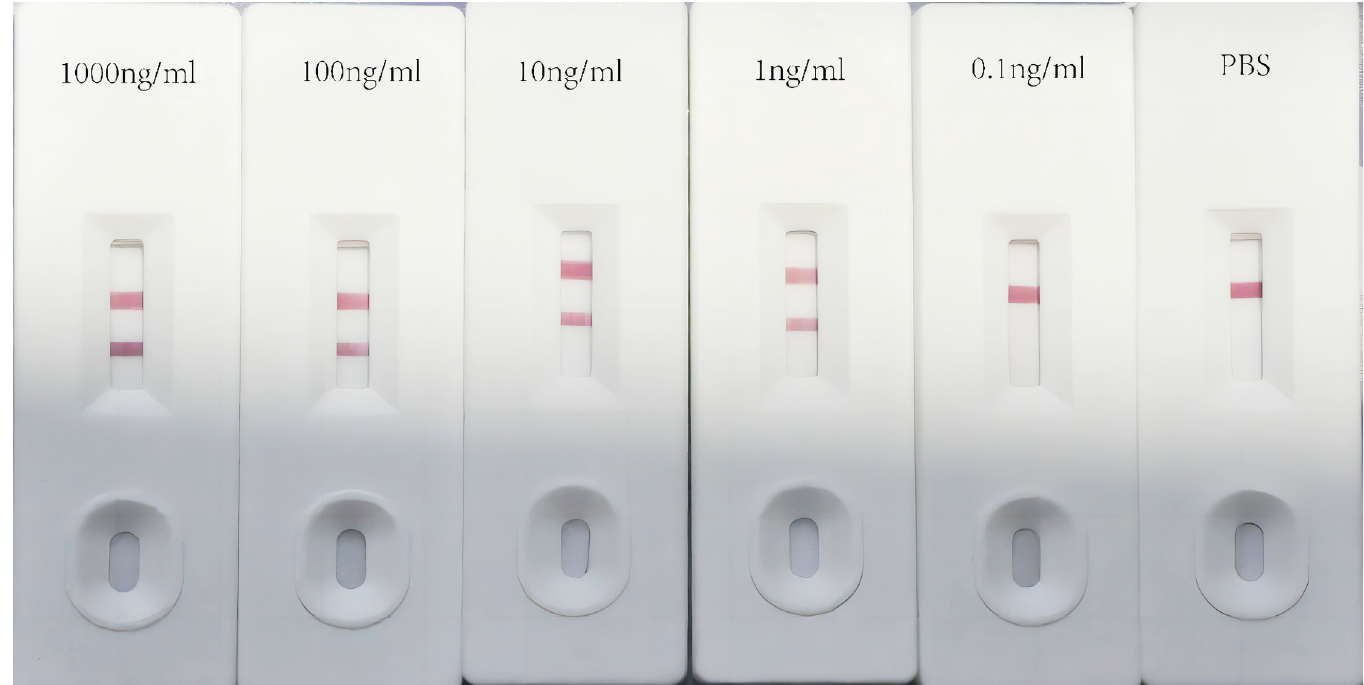
Fig 10. BM venom serially diluted to 1000 to 0.1 ng/ml in PBS and then applied to the LFA for determination of detected ability. Left to right: serial dilutions of applied venoms (1000 to 0.1 ng/ml). PBS used as the negative control. The sensitivity of device was up to 1 ng/ml, as the red line can be seen visually on the strip number 4 in the test region.